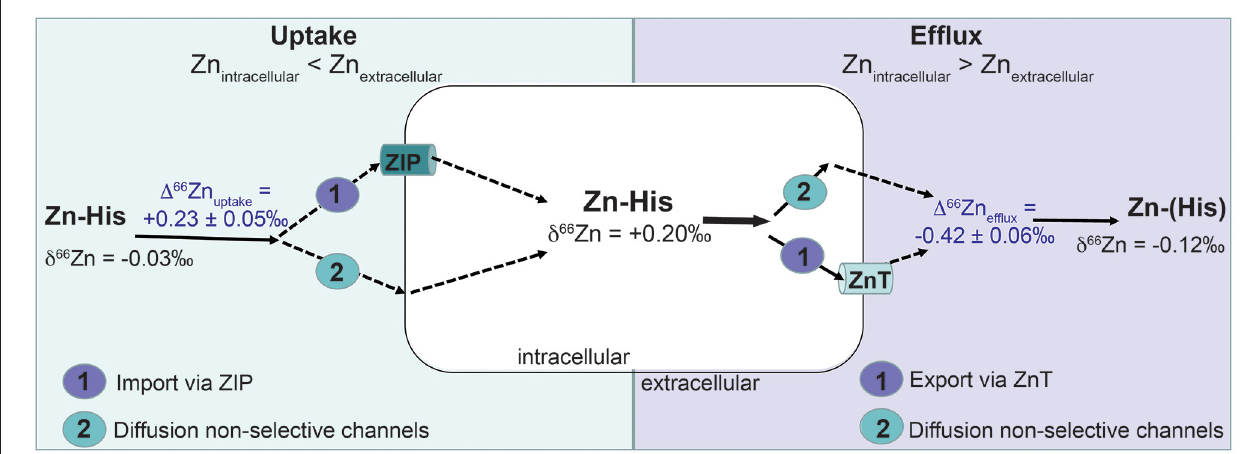
FIGURE 4 | Possible pathways that may lead to Zn isotope fractionation ( 1 66 Zn) based on the uptake-efflux experiment with the MDA-MB-231 cell line. Zn was provided as Zn complexed with histidine (Zn-His). Zn isotope fractionation by cell uptake ( 1 66 Zn uptake ) can be caused by (1) active import of Zn-His via Zn importer proteins (ZIP) or (2) non-quantitative diffusion of Zn via unspecified channels. Zn isotope fractionation via efflux ( 1 66 Zn efflux ) of Zn out of the cells can be caused by (1) active export of Zn-His via Zn transporter proteins (ZnT) or (2) non-quantitative diffusion of Zn via unspecified channels.